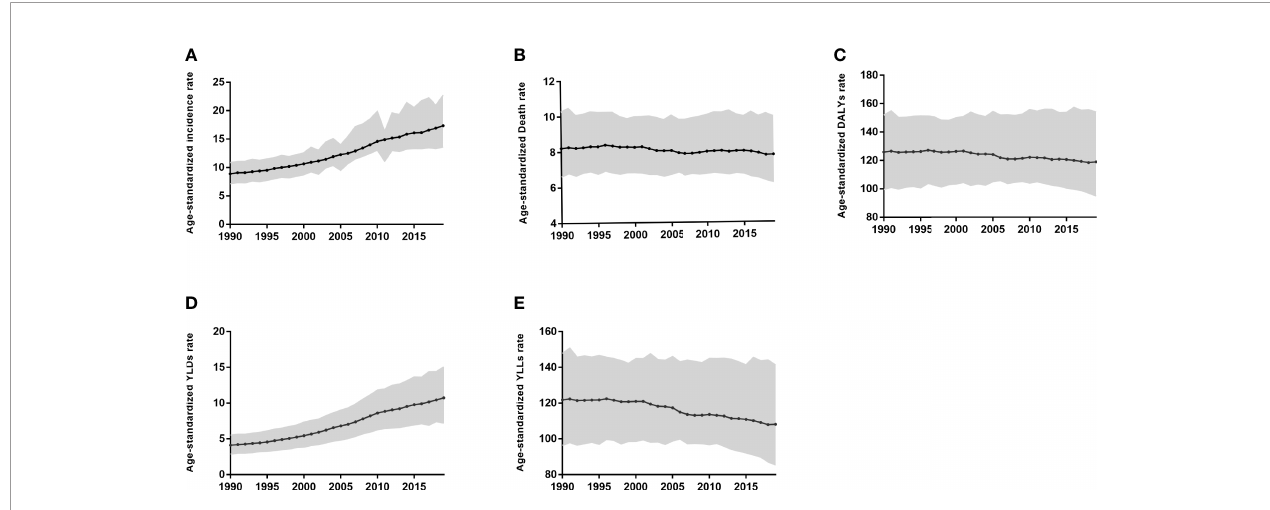
FIGURE 1 | Age-standardized incidence (A) , Death (B) , DALYs (C) , YLDs (D) , and YLLs (E) rate for Prostate Cancer in China from 1990 to